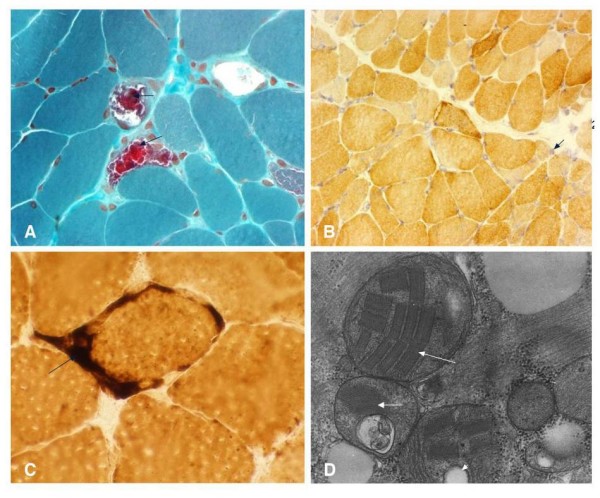
(a) Modified Gomori trichrome stain showing several ragged red fibers (arrowhead). (b) Cytochrome c oxidase stain showing Type-1 lightly stained and Type II fibers, darker fibers, and a few fibers with abnormal collections of mitochondria (arrowhead). Note cytochrome c oxidase negative fibers as usually seen in mitochondrial encephalopathy, lactic acidosis and stroke-like episodes (MELAS). (c) Succinate dehydrogenase staining showing a few ragged blue fibers and intense staining in the mitochondria of the blood vessels (arrow). (d) Electron microscopy showing abnormal collection of mitochondria with paracrystalline inclusions (arrowhead), osmiophilic inclusions (large arrowhead) and mitochondrial vacuoles (small arrowhead).